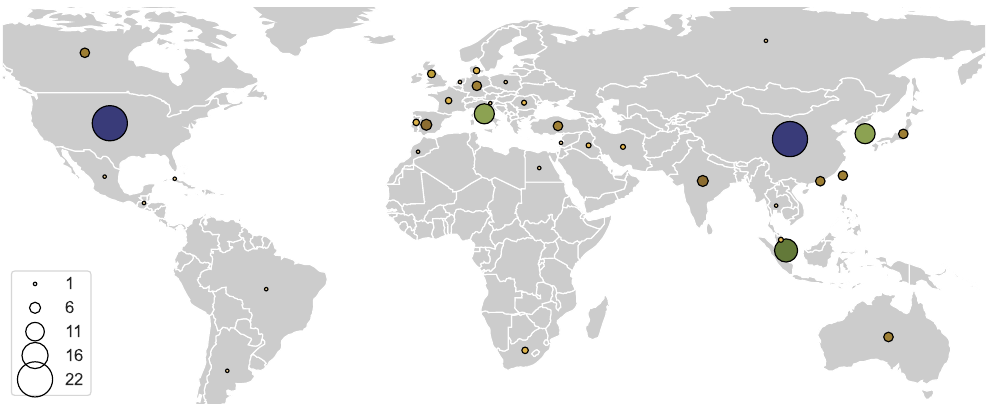
Figure 2. Origin of the examined papers based on first author’s affiliation.